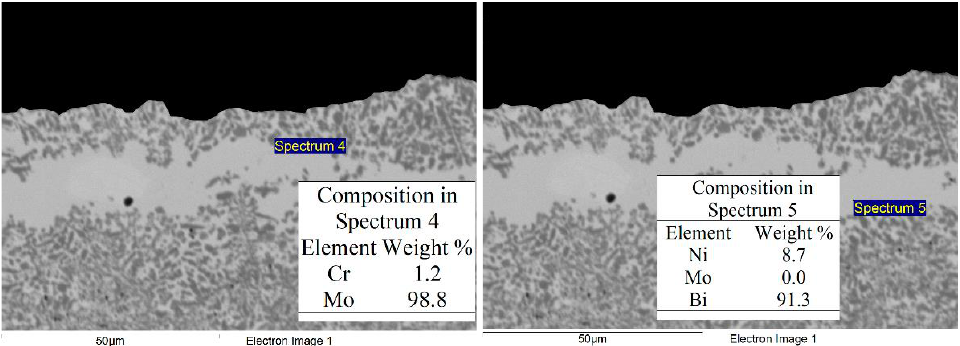
Figure 7. Composition of the surface layer of Hastelloy ® B-3 Alloy samples after 100 h contact with Bi – Li (5 mol.%) alloy at 650 °C.